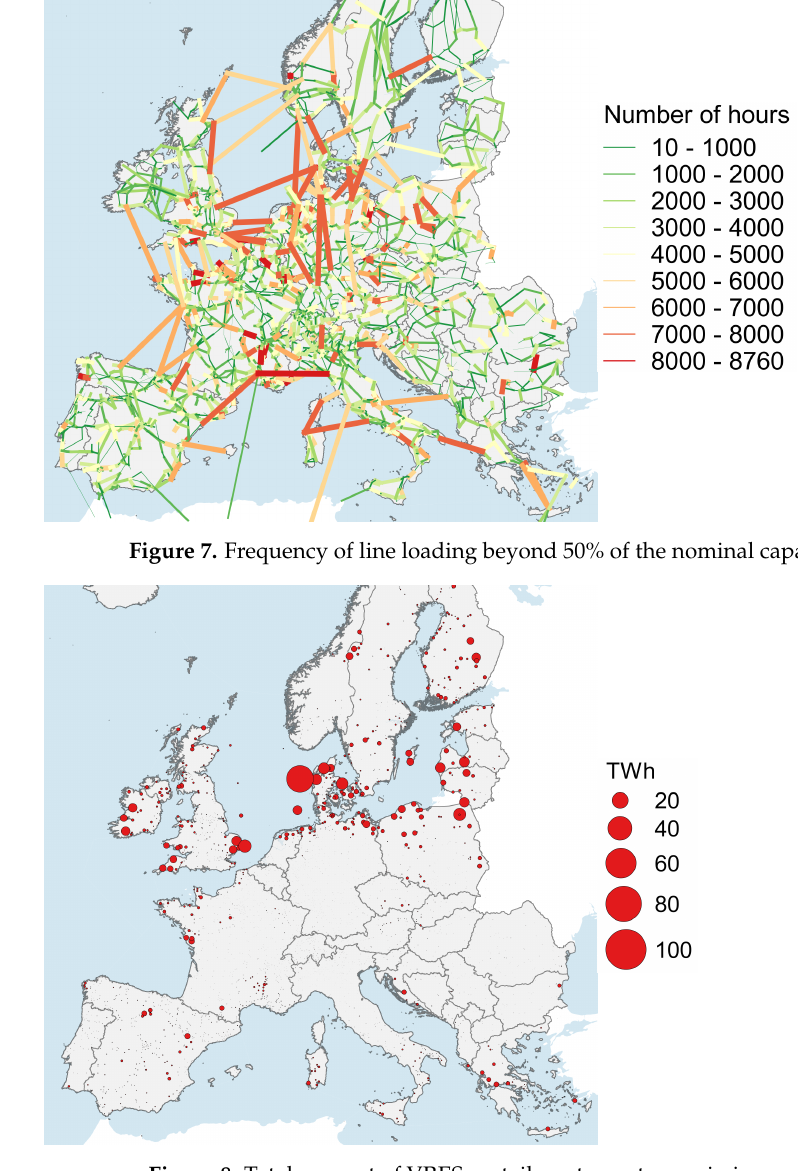
Figure 8. Total amount of VRES curtailments per transmission